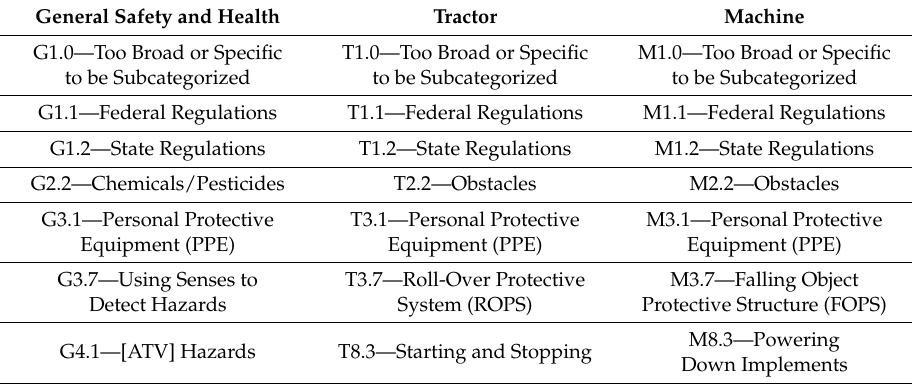
Table 3. Select Tertiary Sub-Classification Categories.